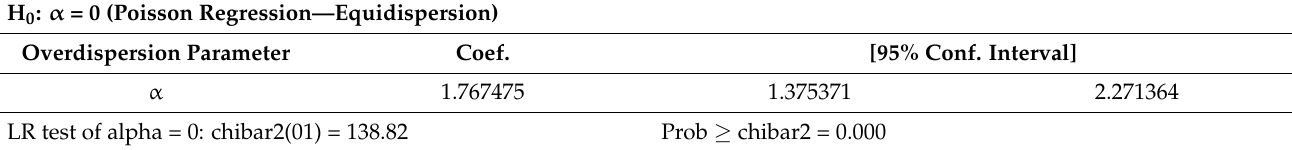
Table A2. Results of LR test for data types ( HHIV